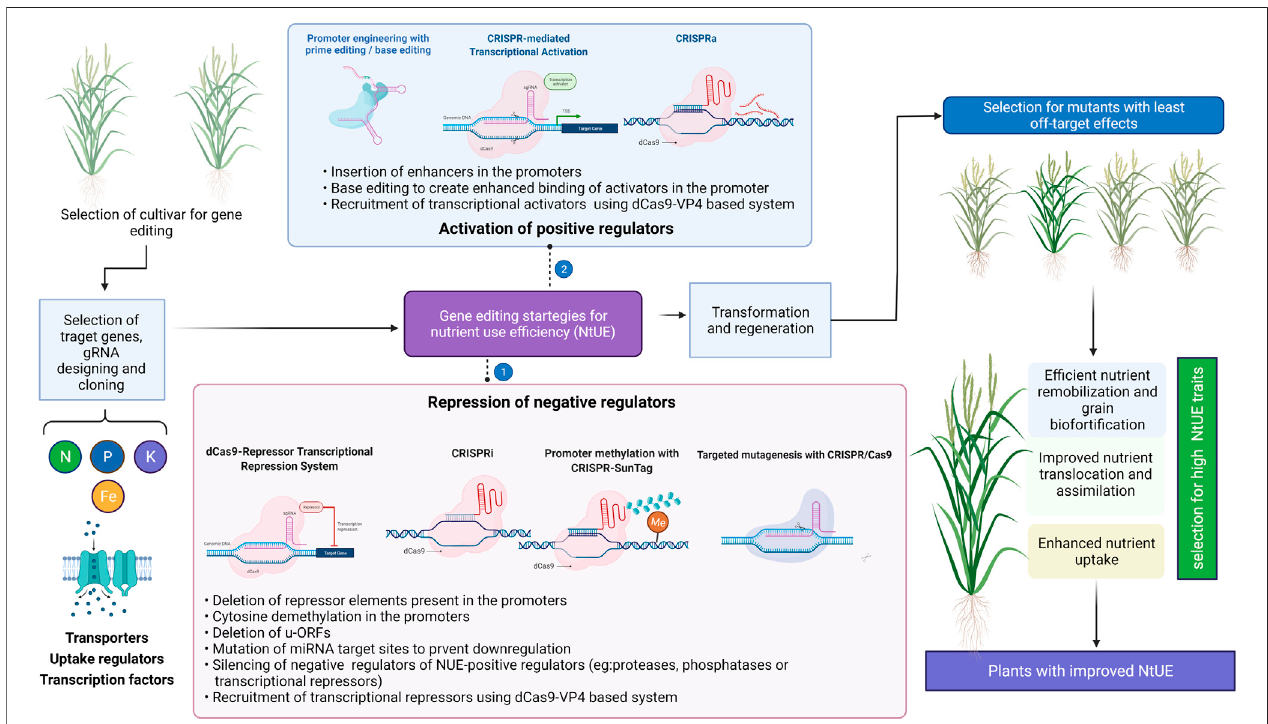
FIGURE 5| Gene editing strategies for improving nutrient use ef fi ciency (NtUE). The approachesto utilize the positive and negative regulators ofthe trait of interest are presented. Illustration was made with Biorender (https://biorender.com/).